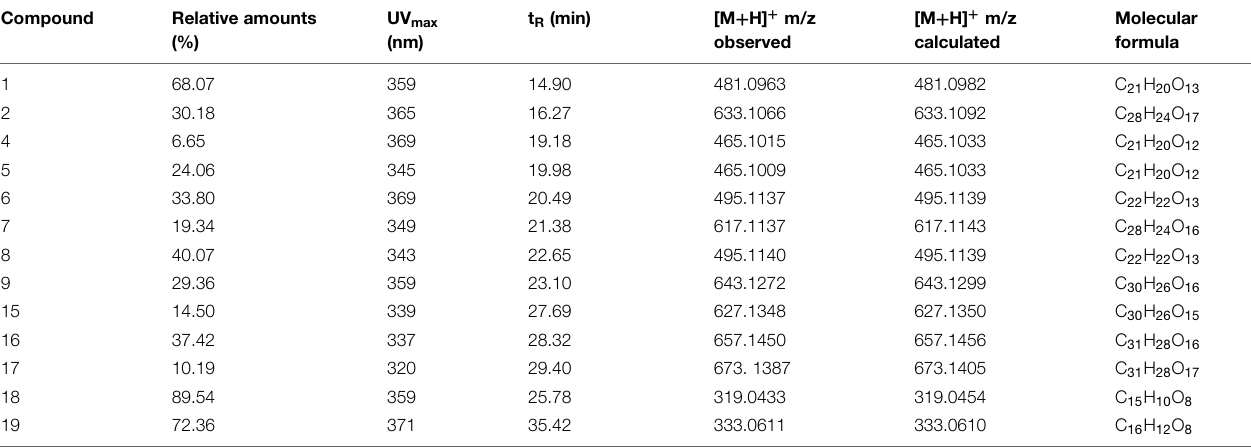
t R (min) [M + H] + m/z UV max (nm) observed